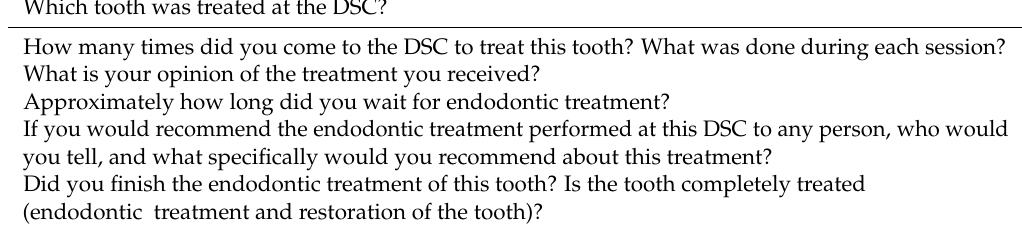
Table 1. Semi-structured interview